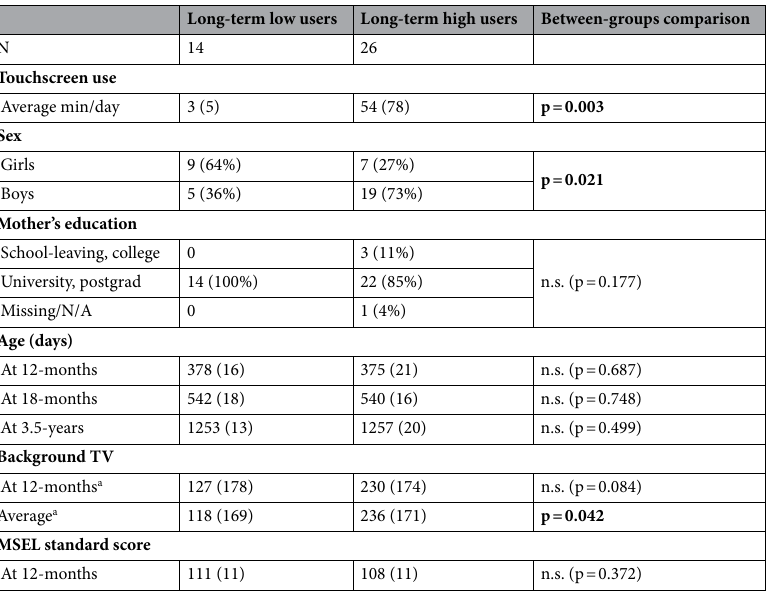
Table 4. Descriptive and frequency statistics for key background variables by long-term touchscreen media user group. For continuous numerical variables data is presented as mean (standard deviation) and difference between user groups (high and low users) was tested with an independent samples t-test. For categorical variables data is presented as N (proportion) and difference between user groups (high and low users) was tested with a Pearson Chi-Square. Significant results are in bold a One value that exceed 3 standard deviations from the mean were trimmed (i.e. changed to be one more than the non-trimmed highest